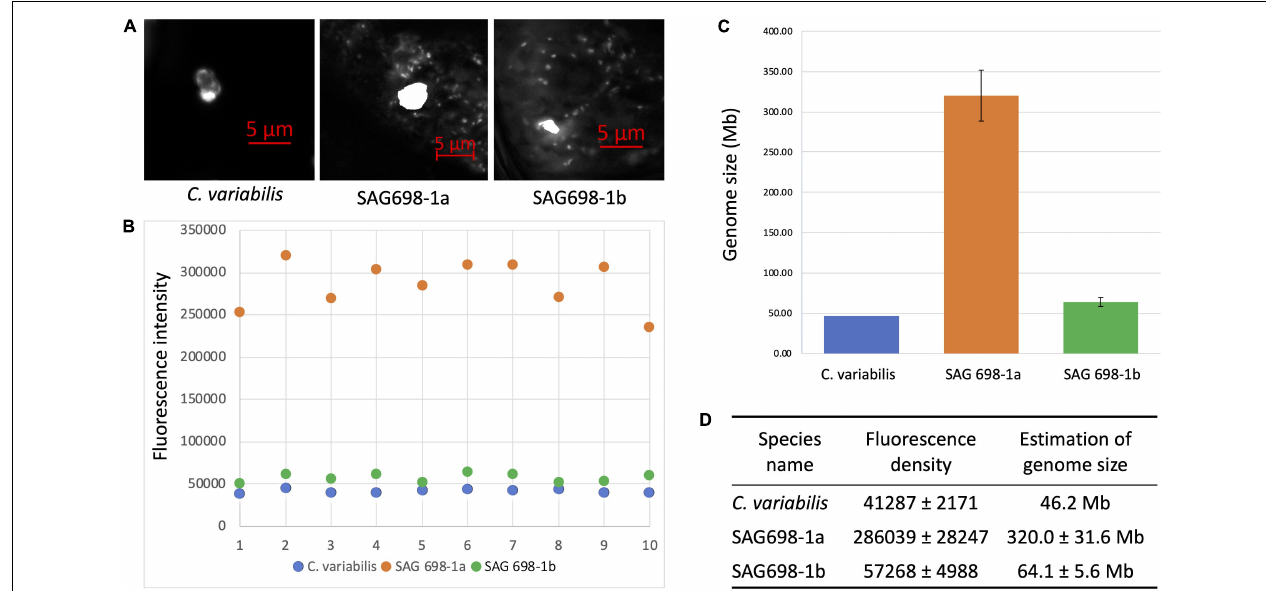
FIGURE 7 | DAPI staining DNA fluorescence analysis of SAG 698-1a and SAG 698-1b. (A) DAPI stained nucleus images of Chlorella variabilis , SAG 698-1a and SAG 698-1b; (B) Fluorescence intensity of nuclei in the cells; (C,D) Genome size calculation of SAG 698-1a and SAG 698-1b (mean values ± SD) using C. variabilis as the reference (known genome